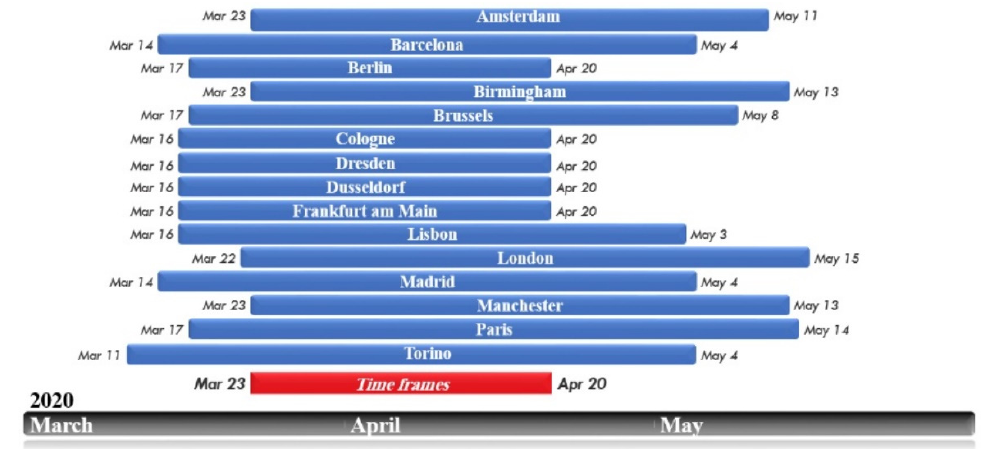
Figure 16. Time periods for executing severe restrictions on COVID − 19 in European cities, and the time frame for conducting this study is shown in the red box. Table 8. Differences in NUHI, NLST, NL, and NO 2 changes during the lockdown compared to its previous year in European major cities.